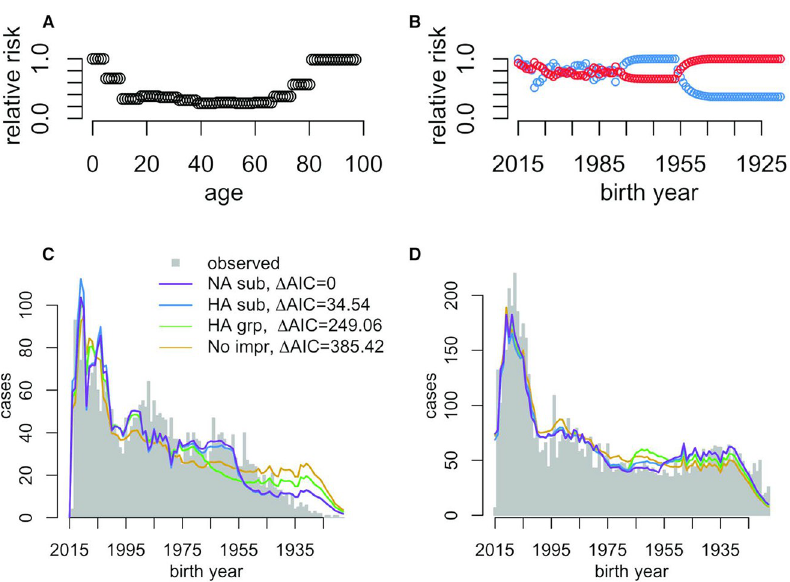
Fig 3. Model fits and model selection. (A) Fitted effects of age, after controlling for demographic age distribution and (B) imprinting effects from the NA subtype-level imprinting model, which provided the best fit to data . (C-D) Model fits to observed age distributions of H1N1 ( C) and H3N2 (D ) case. All models included demographic age distribution and age-specific risk.